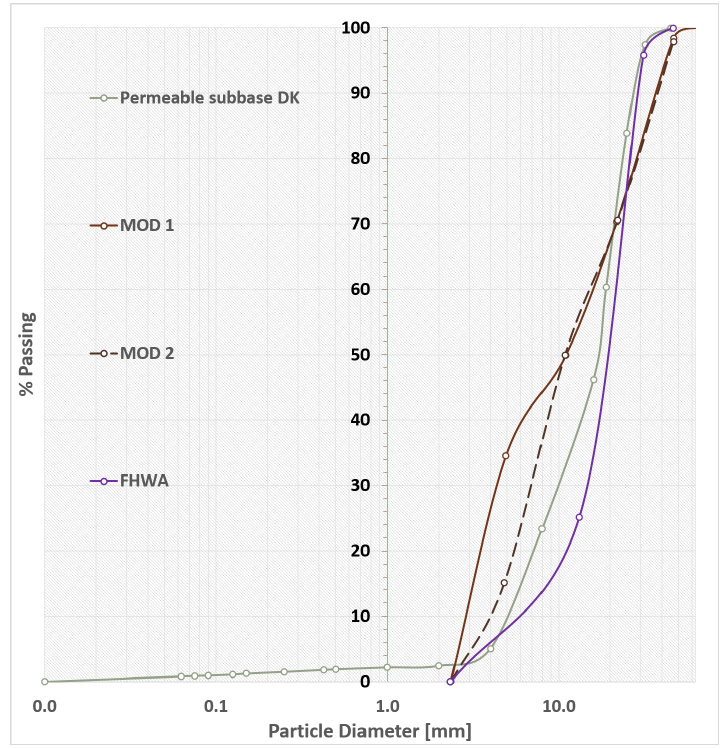
Figure 8. Different experiences with permeable subbase materials